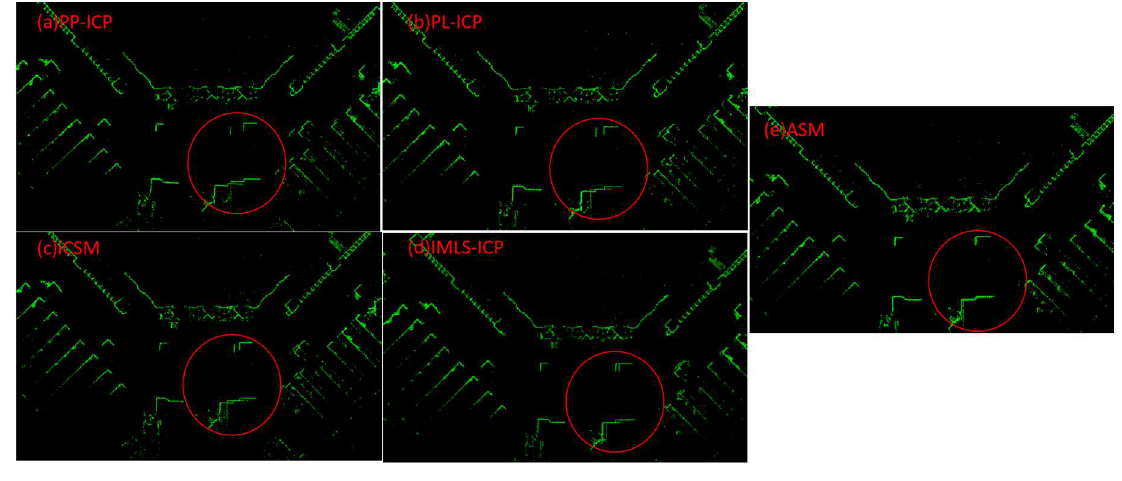
Table 1. End-to-end error statistics